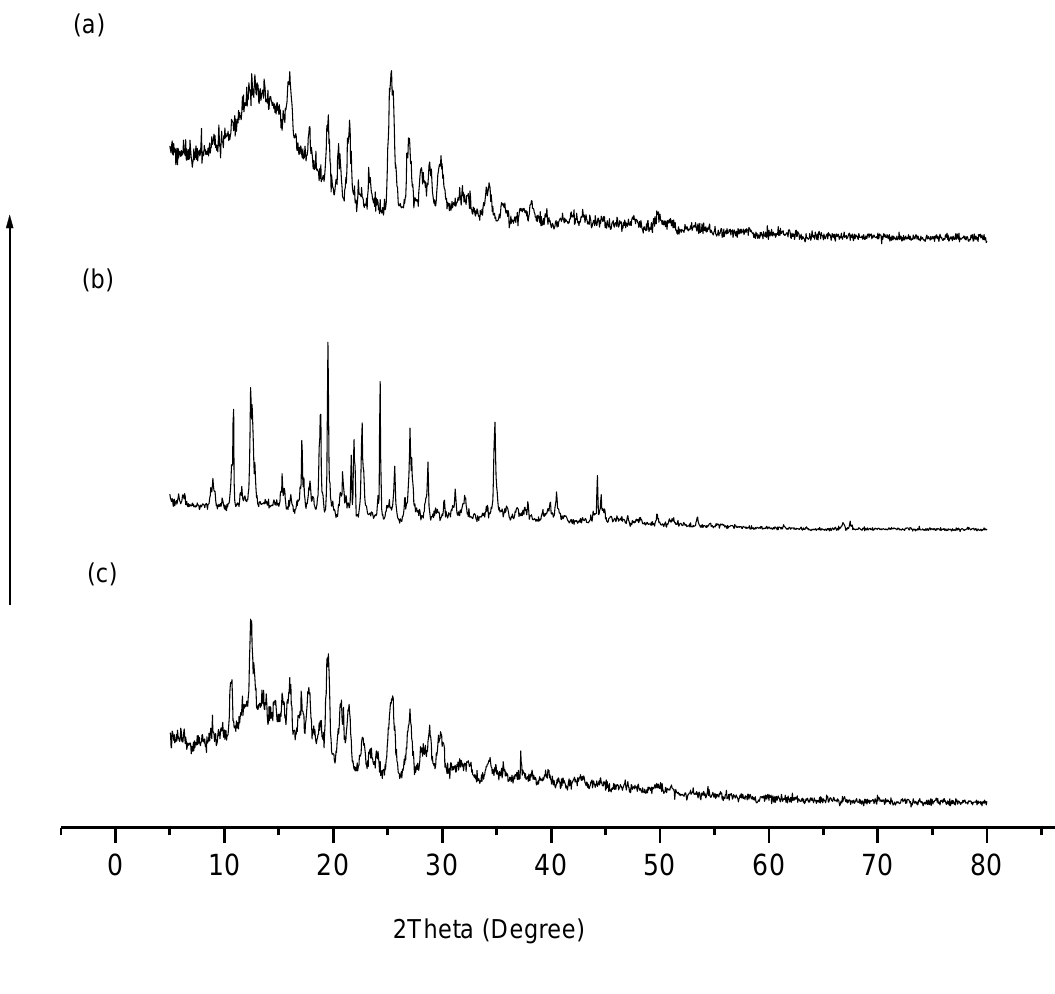
Figure 4. X-ray diffractograms of ( a ) TetraPhimBr, ( b ) β-CD and ( c )